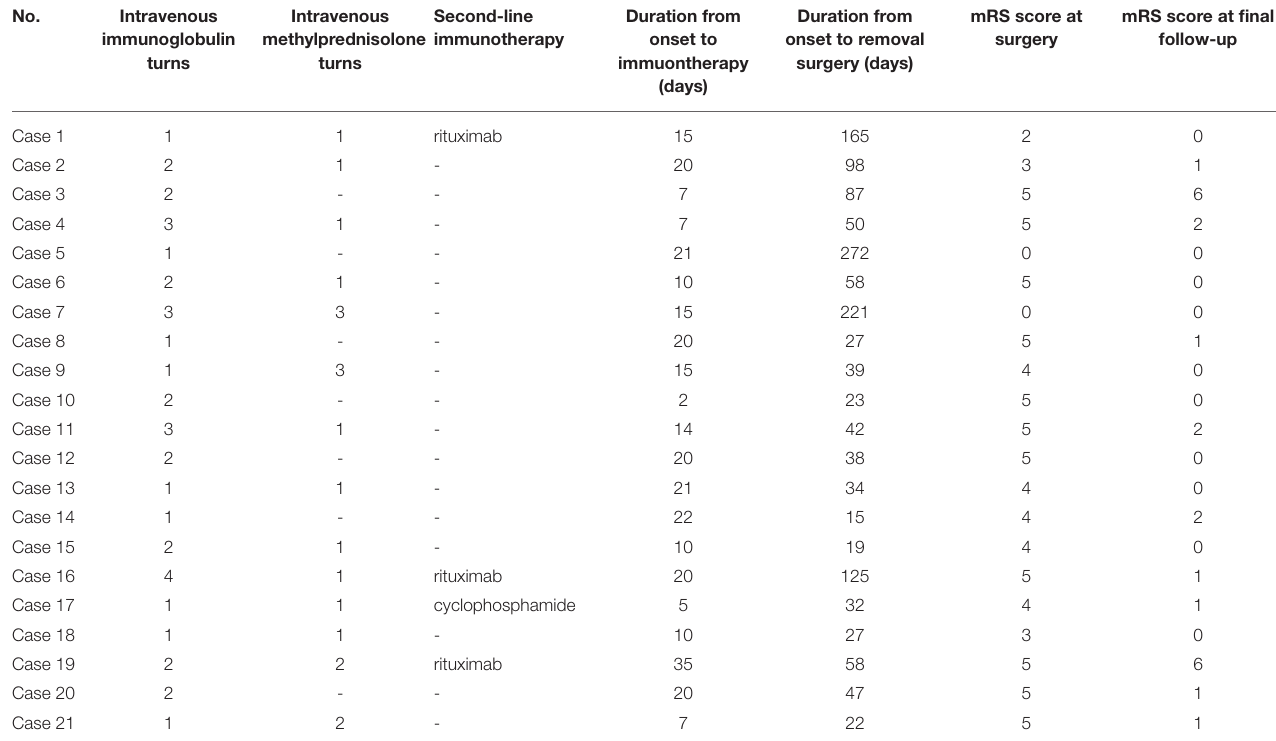
TABLE 3 | Management and outcomes of patients with teratoma. No. Intravenous